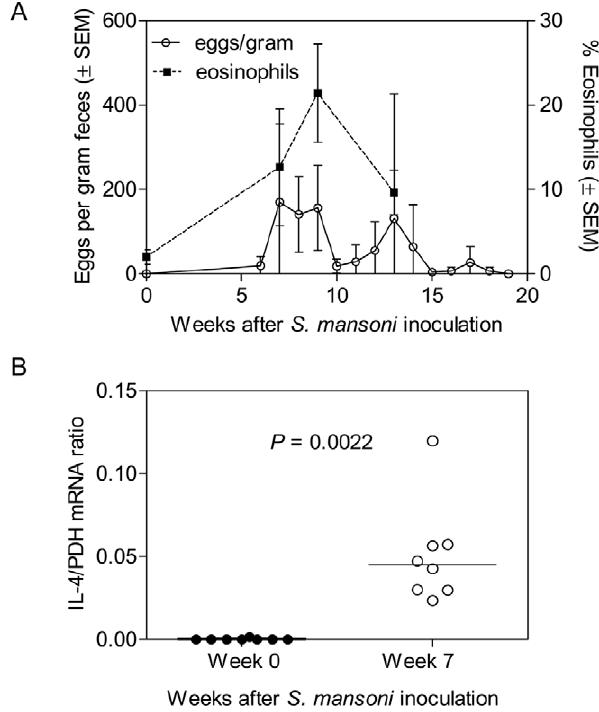
Figure 1. Infection of Chinese-origin RM with S.mansoni and IL- 4 mRNA expression levels. (A) Egg counts (per gram feces) in stool samples collected from the S. mansoni -infected animals. Data represent the average of three consecutive values 6 SEM. Percentage of eosinophils was plotted as a function of time ( 6 SEM). (B) Ratios of IL-4 mRNA expression relative to the expression of the housekeeping gene (GAPDH) in PBMC before exposure to S. mansoni (week 0) and at week 7 (before exposure to SHIV-C).